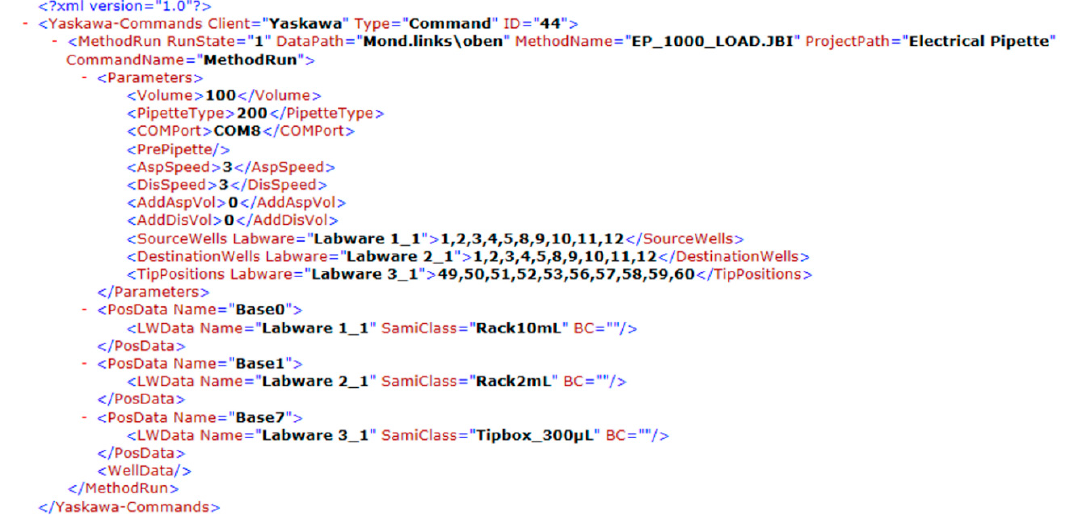
Figure 13. XML message sent from SAMI to the R–interface.